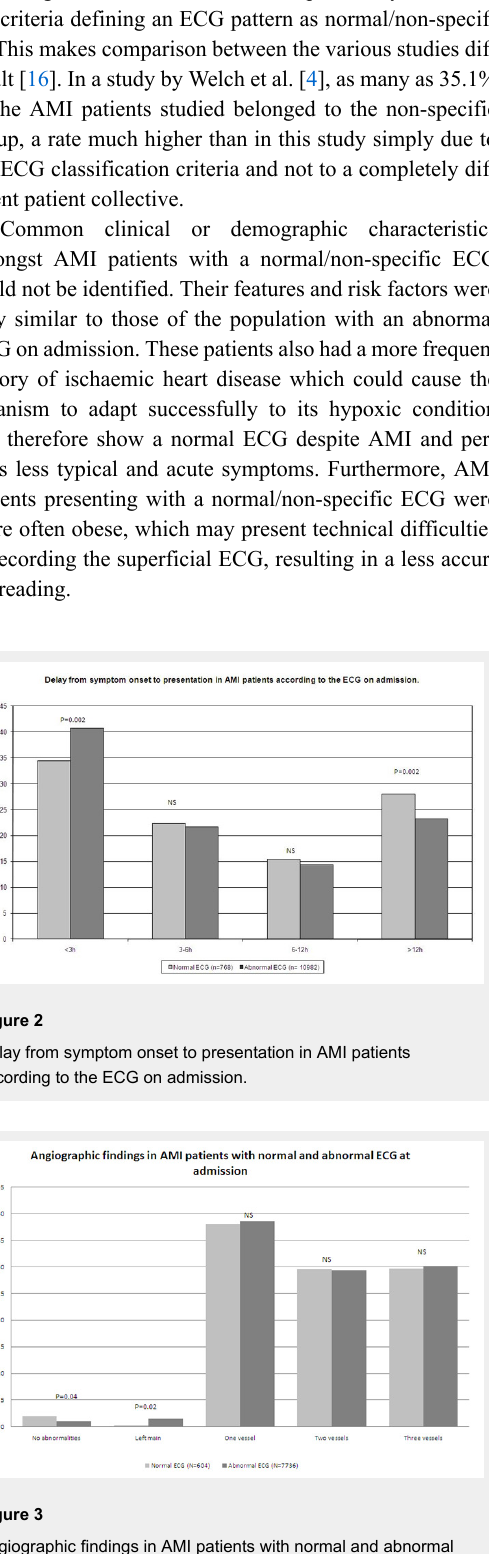
Angiographic findings in AMI patients with normal and abnormal ECG at